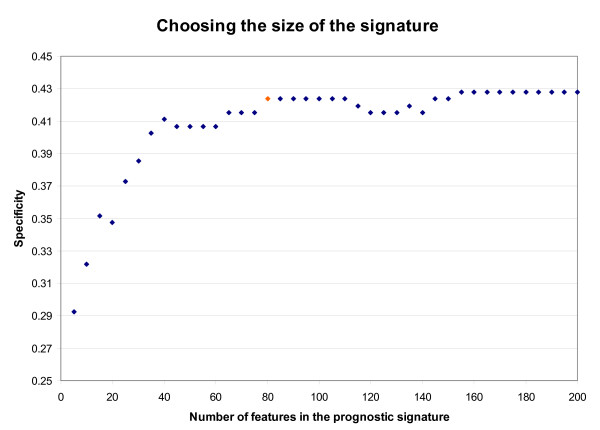
Choosing size of the signature. The relationship between the number of features in a prognostic signature and the specificity at 90% sensitivity of the corresponding prognostic test, evaluated by 40-fold cross-validation. We select mopt = 80, the smallest value that achieves roughly maximum specificity at the 90% sensitivity level. The specificity observed on the validation set is in fact higher.